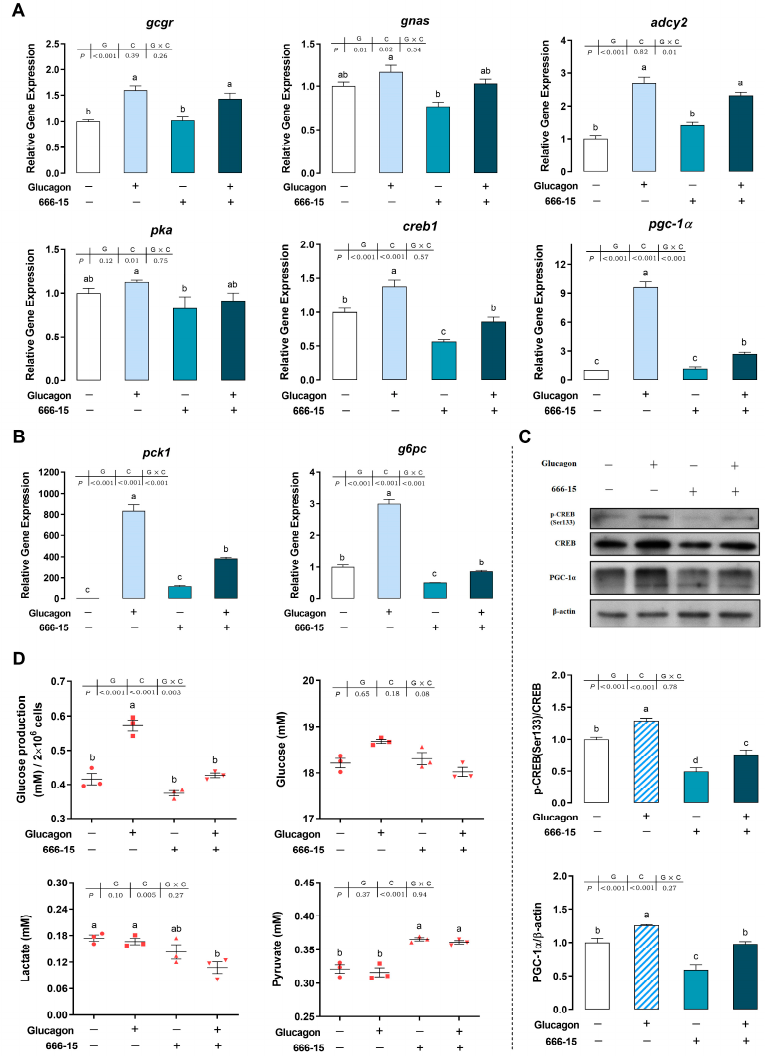
Figure 7. The compound 666-15 inhibits the glucagon pathway in hepatocytes by targeting CREB. ( A ), qPCR analysis of the mRNA levels of glucagon pathway-related genes ( gcgr ; gnas ; adcy2 ; pka ; creb1 ; pgc-1 α ) following glucagon stimulation and treatment with 666-15 (40 µM) in hepatocytes. ( B ), qPCR analysis of the mRNA levels of gluconeogenic genes ( pck1 and g6pc ) following glucagon stimulation and treatment with 666-15 (40 µM) in hepatocytes. ( C ), Western blot analysis of p-CREB (Ser 133 ) and PGC-1 α following glucagon stimulation and treatment with 666-15 (40 µM) in hepatocytes. ( D ), Glucose production in hepatocytes and glucose, lactate, and pyruvate concentrations in the medium following glucagon stimulation and treatment with 666-15 (40 µ M). All data are expressed as mean ± SE, n = 3, two-way ANOVA with Tukey post-hoc test. Values with different letters mean statistical differences ( p < 0.05). G: glucagon treatments; C: 666-15 treatments; G × C: interaction between glucagon and 666-15